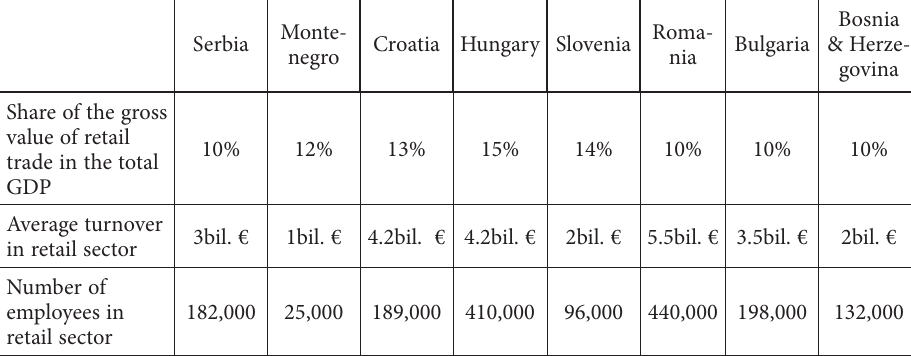
Monte- Serbia Croatia Hun gary Slovenia negro